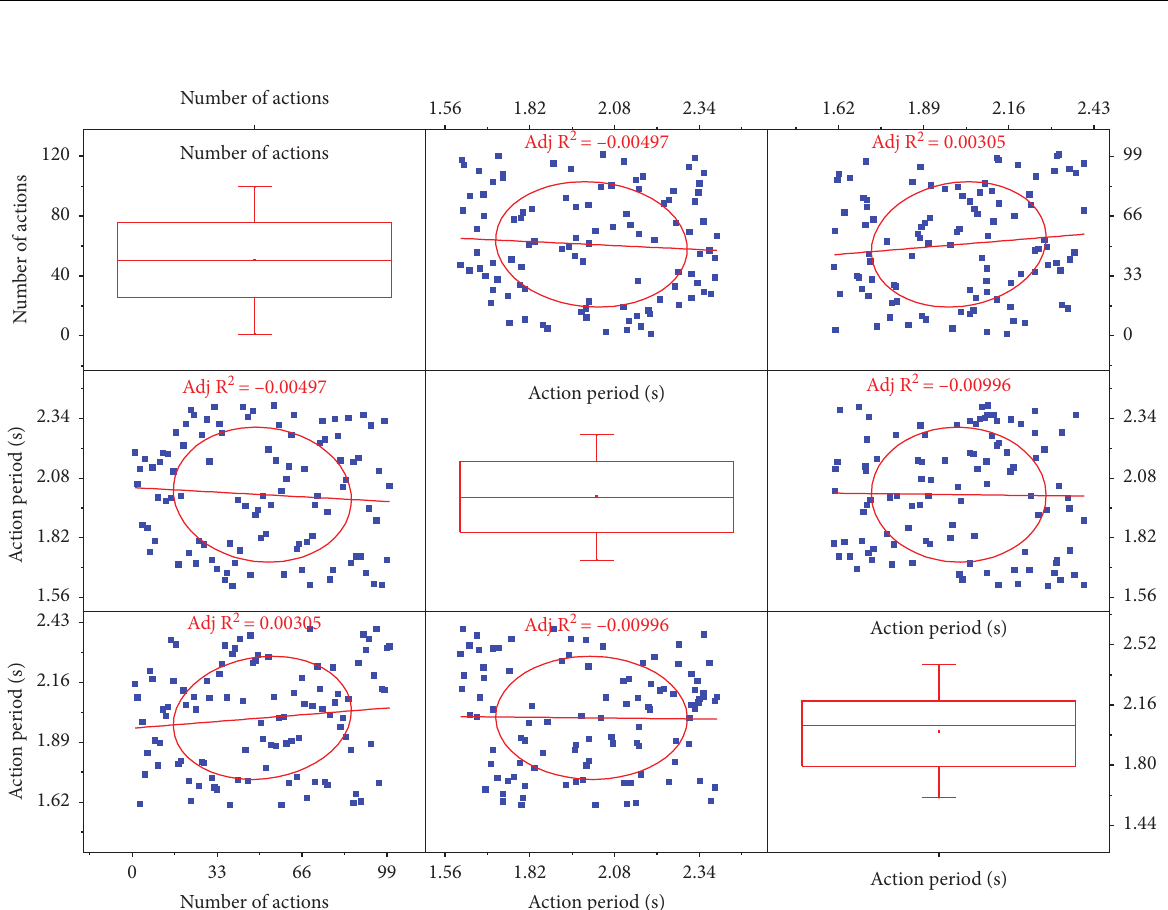
Figure 8: Motion count and cycle calculation results.